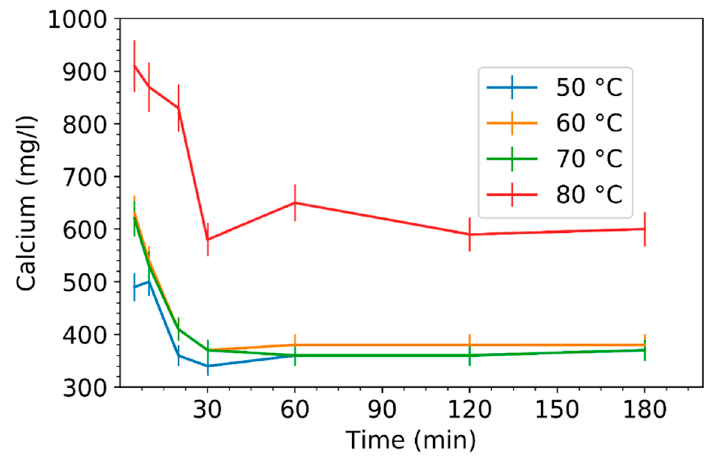
Figure 11. Calcium concentrations as a function of time at 420 g / L S / L using citric acid as reducing agent.